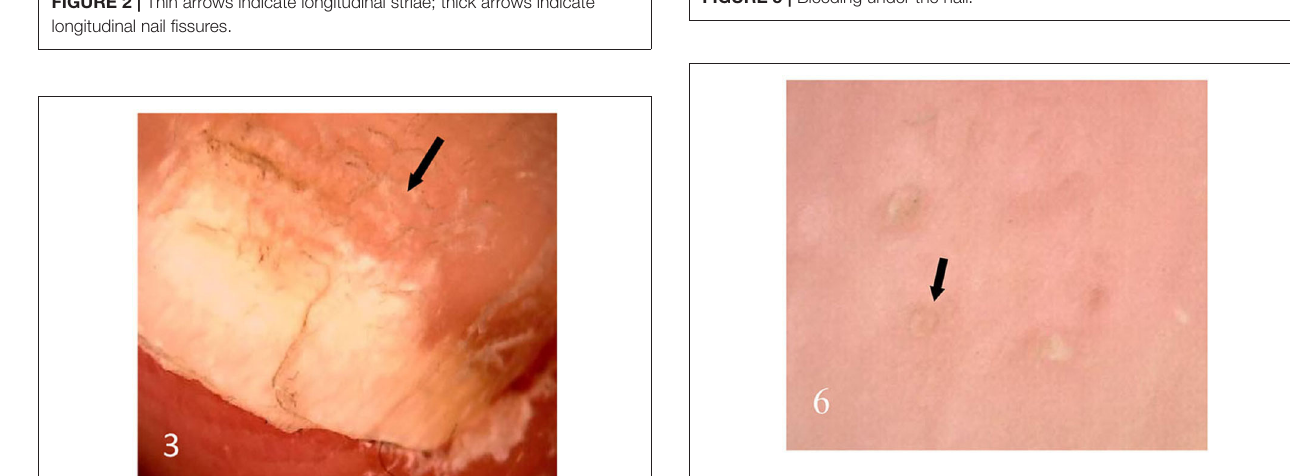
FIGURE 5 | Bleeding under the nail.